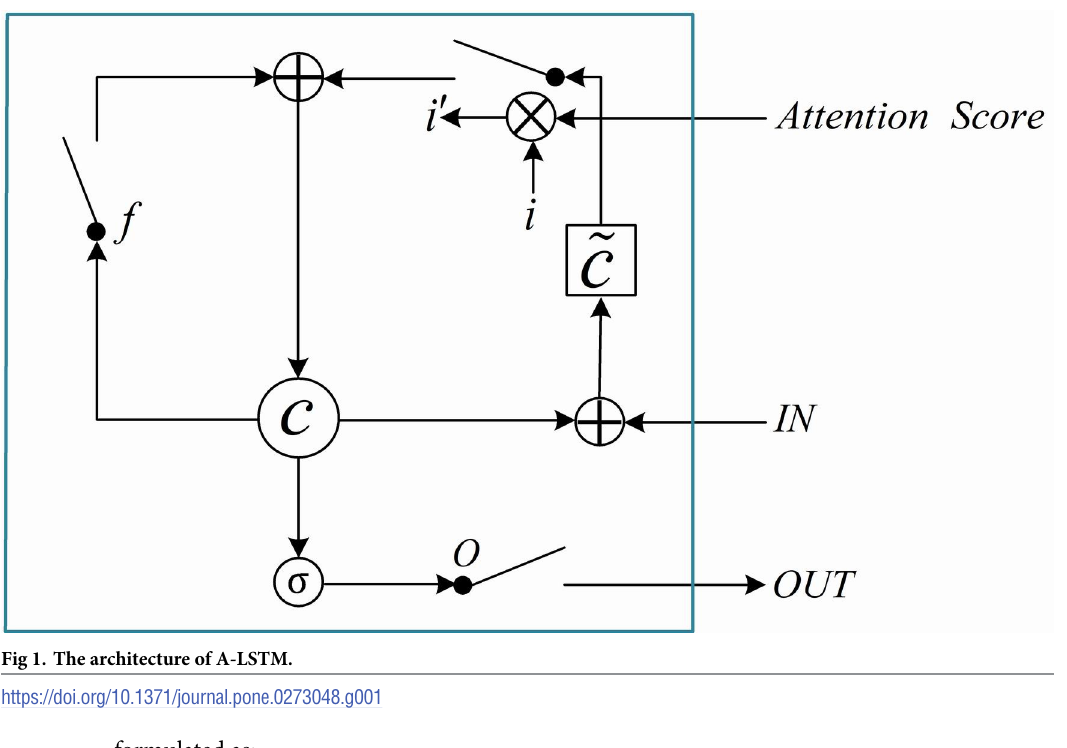
Fig 1. The architecture of